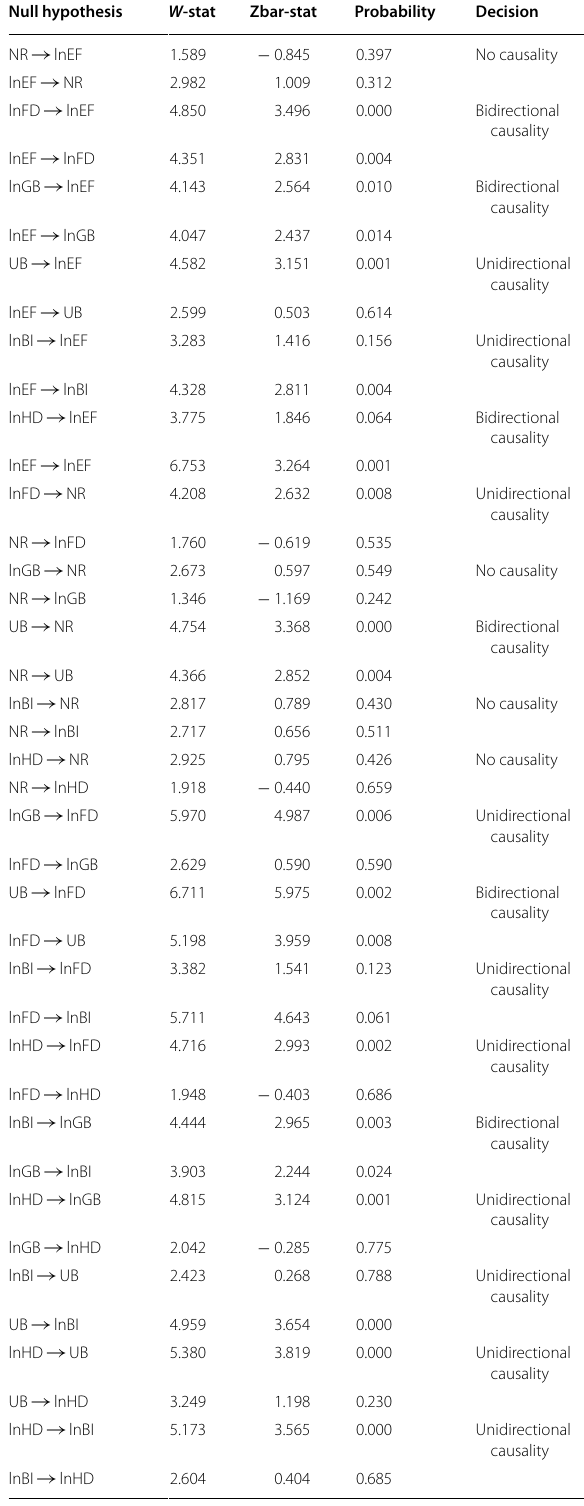
Table 11 D–H causality